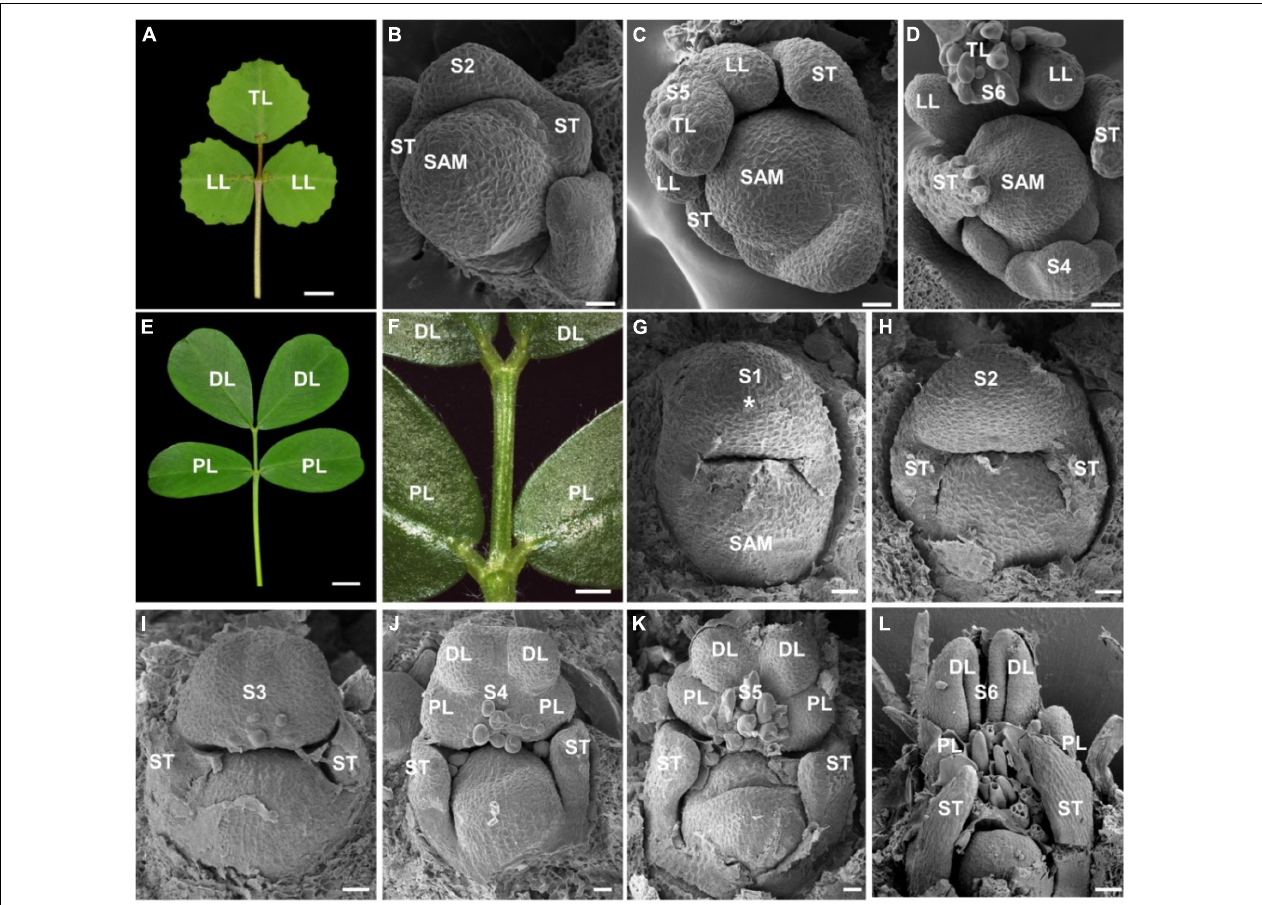
FIGURE 1 | The ontogeny of compound leaf development in Medicago truncatula and Arachis hypogaea . (A) The mature leaf morphology of M. truncatula . (B–D) Different stages of compound leaf development in M. truncatula . (B) Stage 2. A pair of stipule primordia (ST) were initiated from leaf primordium. (C) Stage 5. The common leaf primordium differentiated into a pair of lateral leaflet primordia (LL) and a terminal leaflet primordium (TL). (D) Stage 6. Trichomes were developed on terminal leaflet primordium. (E,F) Fully expanded compound leaf of A. hypogaea . A close-up view is shown in panel (F) . (G–L) The Scanning Electron Microscopy (SEM) analysis of the ontogeny of leaf development in A. hypogaea . (G) Stage 1. Leaf primordium (asterisk) initiates and grows to enwrap the SAM. (H) Stage 2. A pair of stipule primordia (ST) were initiated from the proximal end of the leaf primordium. (I) Stage 3. The boundaries formed between the common leaf primordium and stipule leaflet primordia. (J) Stage 4. A pair of proximal leaflet primordia (PL) and a pair of distal leaflet primordia (DL) were formed. (K) Stage 5. Trichomes were developed. (L) Stage 6. The leaflet primordia became folded. Bars = 0.5 cm in panels (A,E) , 20 µ m in panels (B–D) , 0.2 cm in panel (F) , and 50 µ m in panel (G–L)